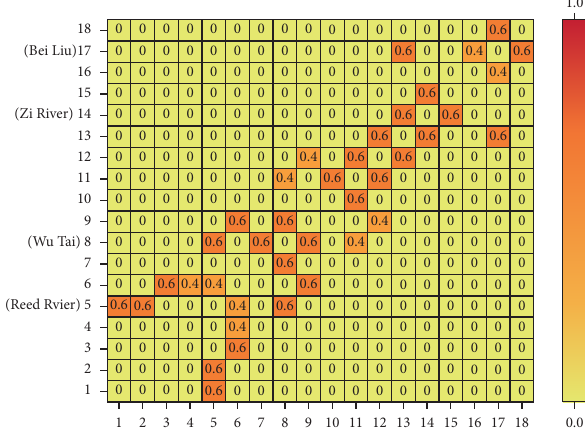
Figure 6: Spatial weight adjacency matrix W (0.6,0.4) for classified roads.